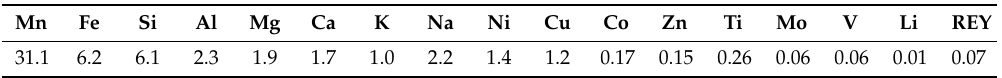
Table 1. Average chemical composition (wt %) of polymetallic nodules from the eastern German license area within the Clarion and Clipperton Zone (CCZ; N = 741; data from the Federal Institute for Geosciences and Natural Resources